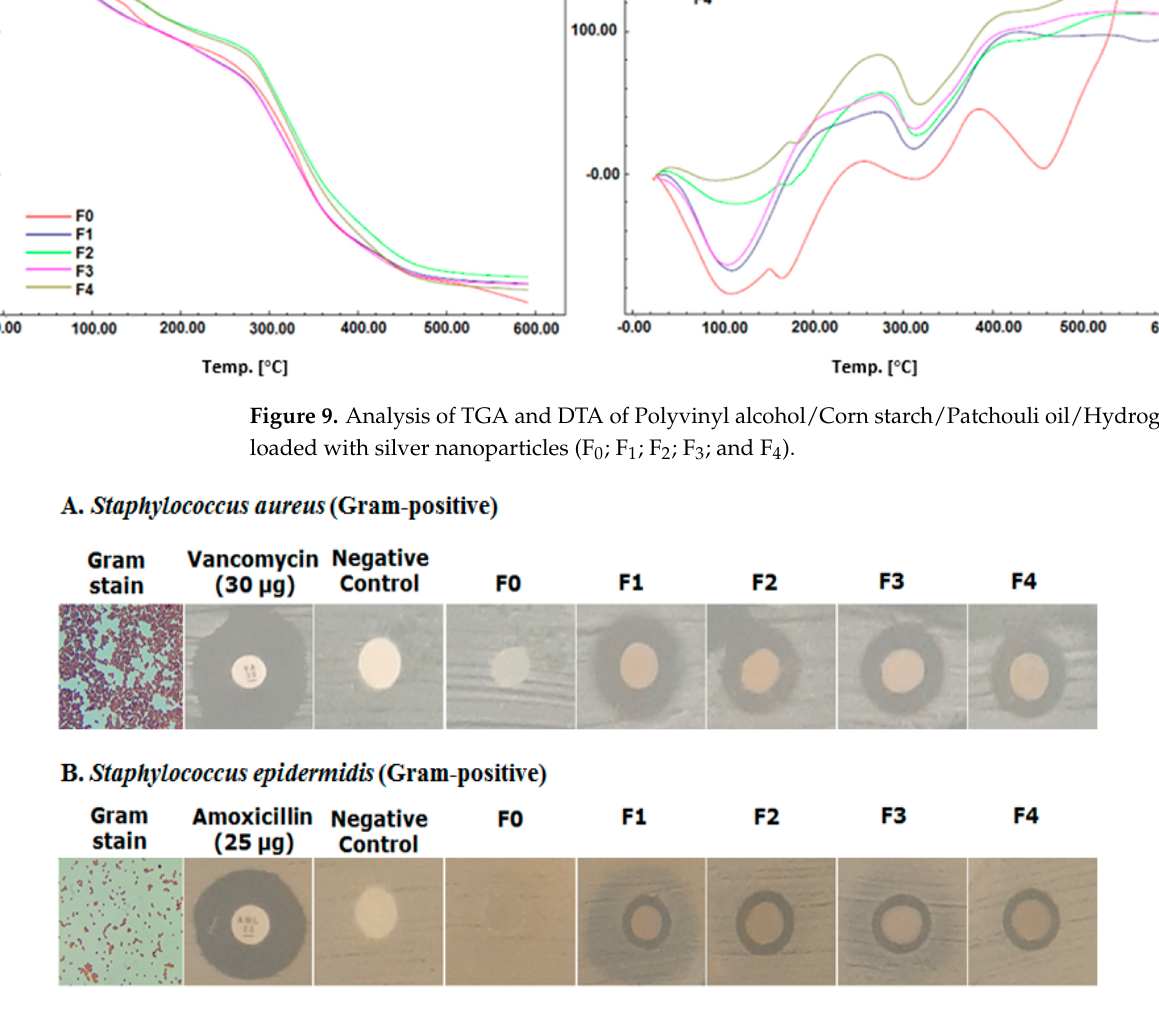
Figure 10. Antimicrobial activity test of hydrogel film preparation against S. aureus and S. epidermidis.